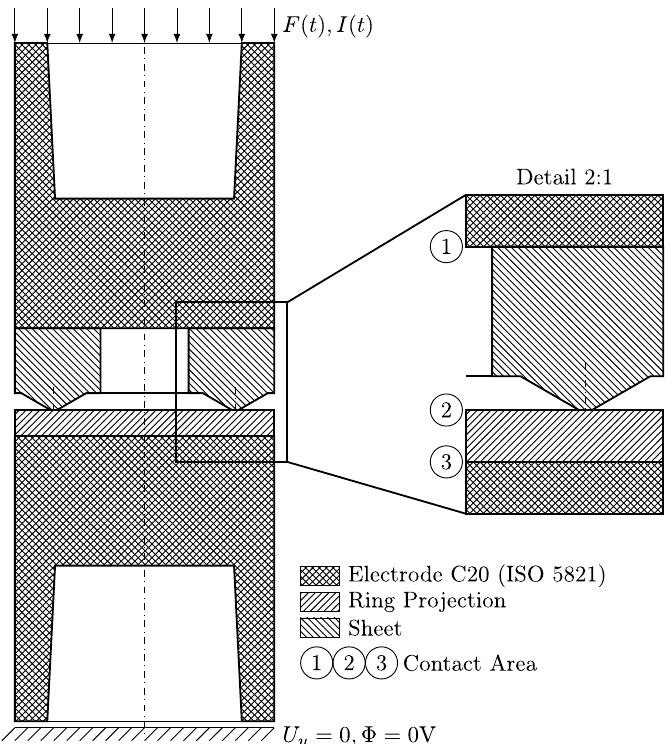
Figure 3. The investigated 2D axisymmetric finite element (FE) model with the applied loads and boundary conditions. Detailed view of the contact areas and the investigated ring